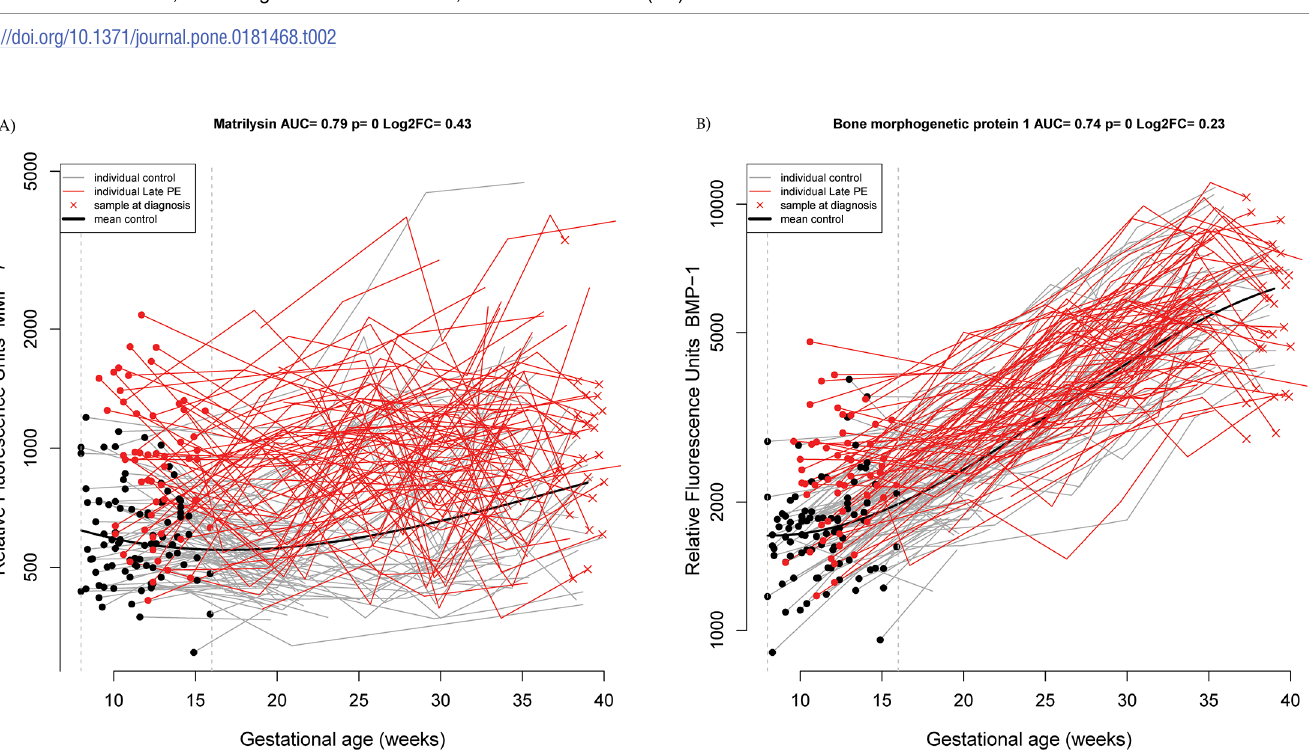
PLOS ONE | https://doi.org/10.1371/journal.pone.0181468 July 24,